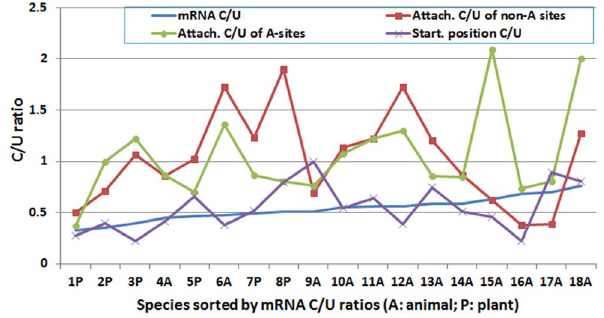
Figure 4. The C/U ratios in messenger RNA (mRNA) sequences, the polyadenylation [poly(A)] tail attachment position of A- type poly(A) sites, the poly(A) tail attachment position of non- A-type poly(A) sites, and the poly(A) tail starting position. The species were sorted from smallest (1) to largest (18) by their mRNA C/U ratios. The order of species from 1 to 18 is Medicago truncatula (1P), Arabidopsis thaliana (2P), poplar (3P), zebrafish (4A), rice (5P), chicken (6A), sorghum (7P), maize (8P), fruit fly (9A), cattle (10A), orangutan (11A), zebra finch (12A), human (13A), mouse (14A), rat (15A), dog (16A), rabbit (17A), and pig (18A). Note that a) there was no correlation between the C/U ratio at the poly(A) site and the mRNA C/U ratio; b) the C/U ratios at the poly(A) attachment position were usually much higher than the mRNA C/U ratios, a finding that means that C was positively selected over U to a certain degree at the poly(A) tail attachment position; and c) the poly(A) starting position did not have this preference for C over